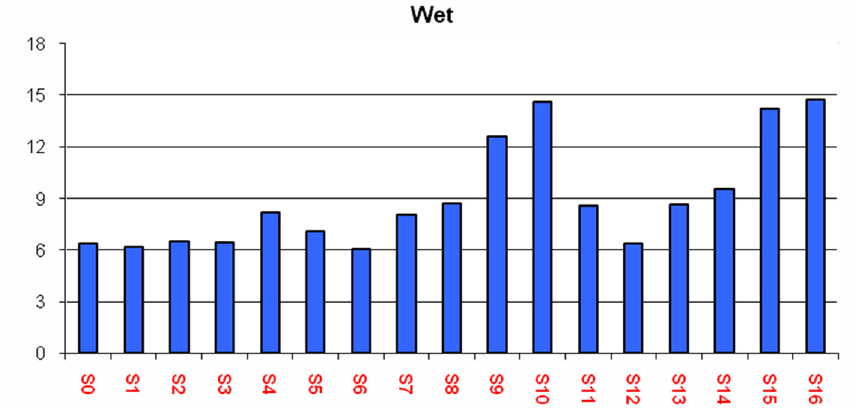
Figure 4. Height of water table under different economic scenarios in Normal climate condition on the planning horizon